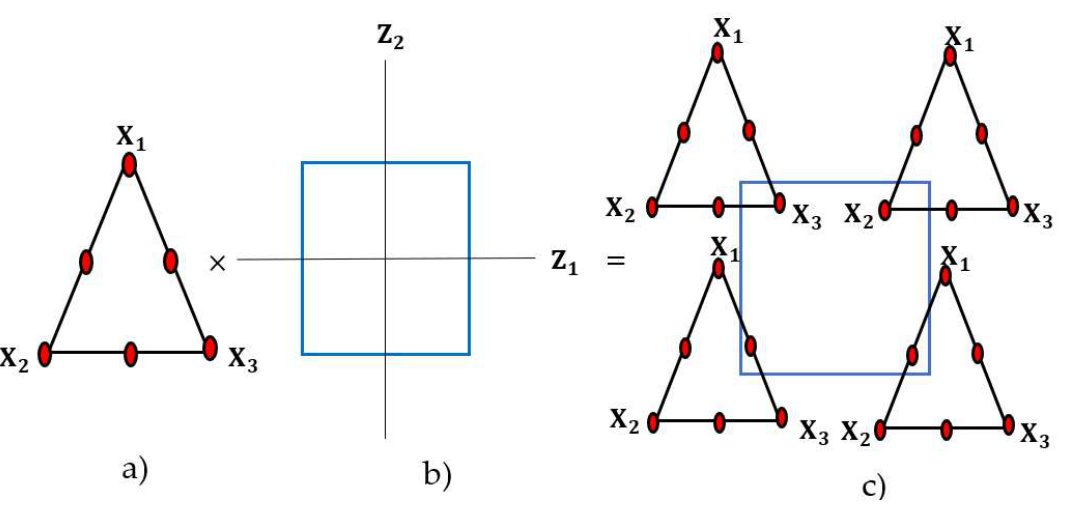
Figure 2. Experimental points in the combined design: ( a ) mixture design for three components; ( b ) factorial design for two process variables; ( c ) combination of mixture components with process variables.